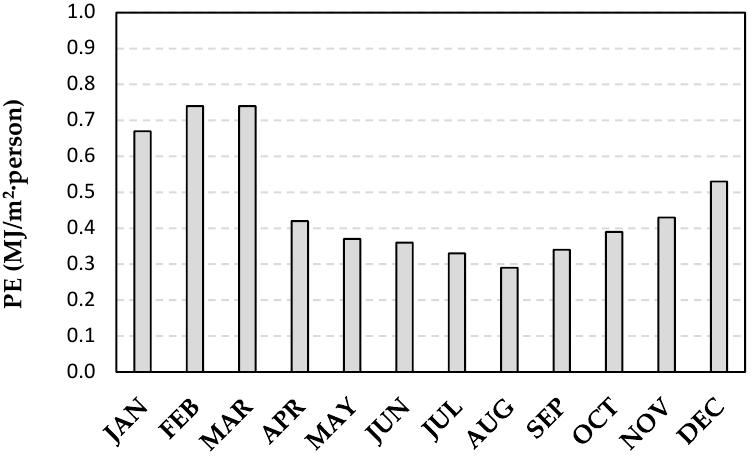
Figure 5. Breakdown of the total primary energy (PE) throughout the year.